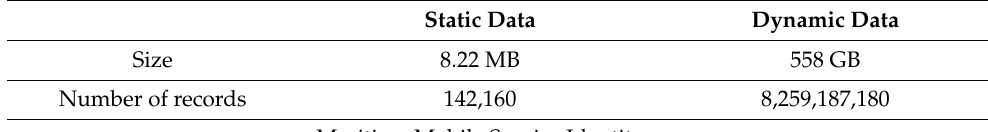
Table 1. Description of